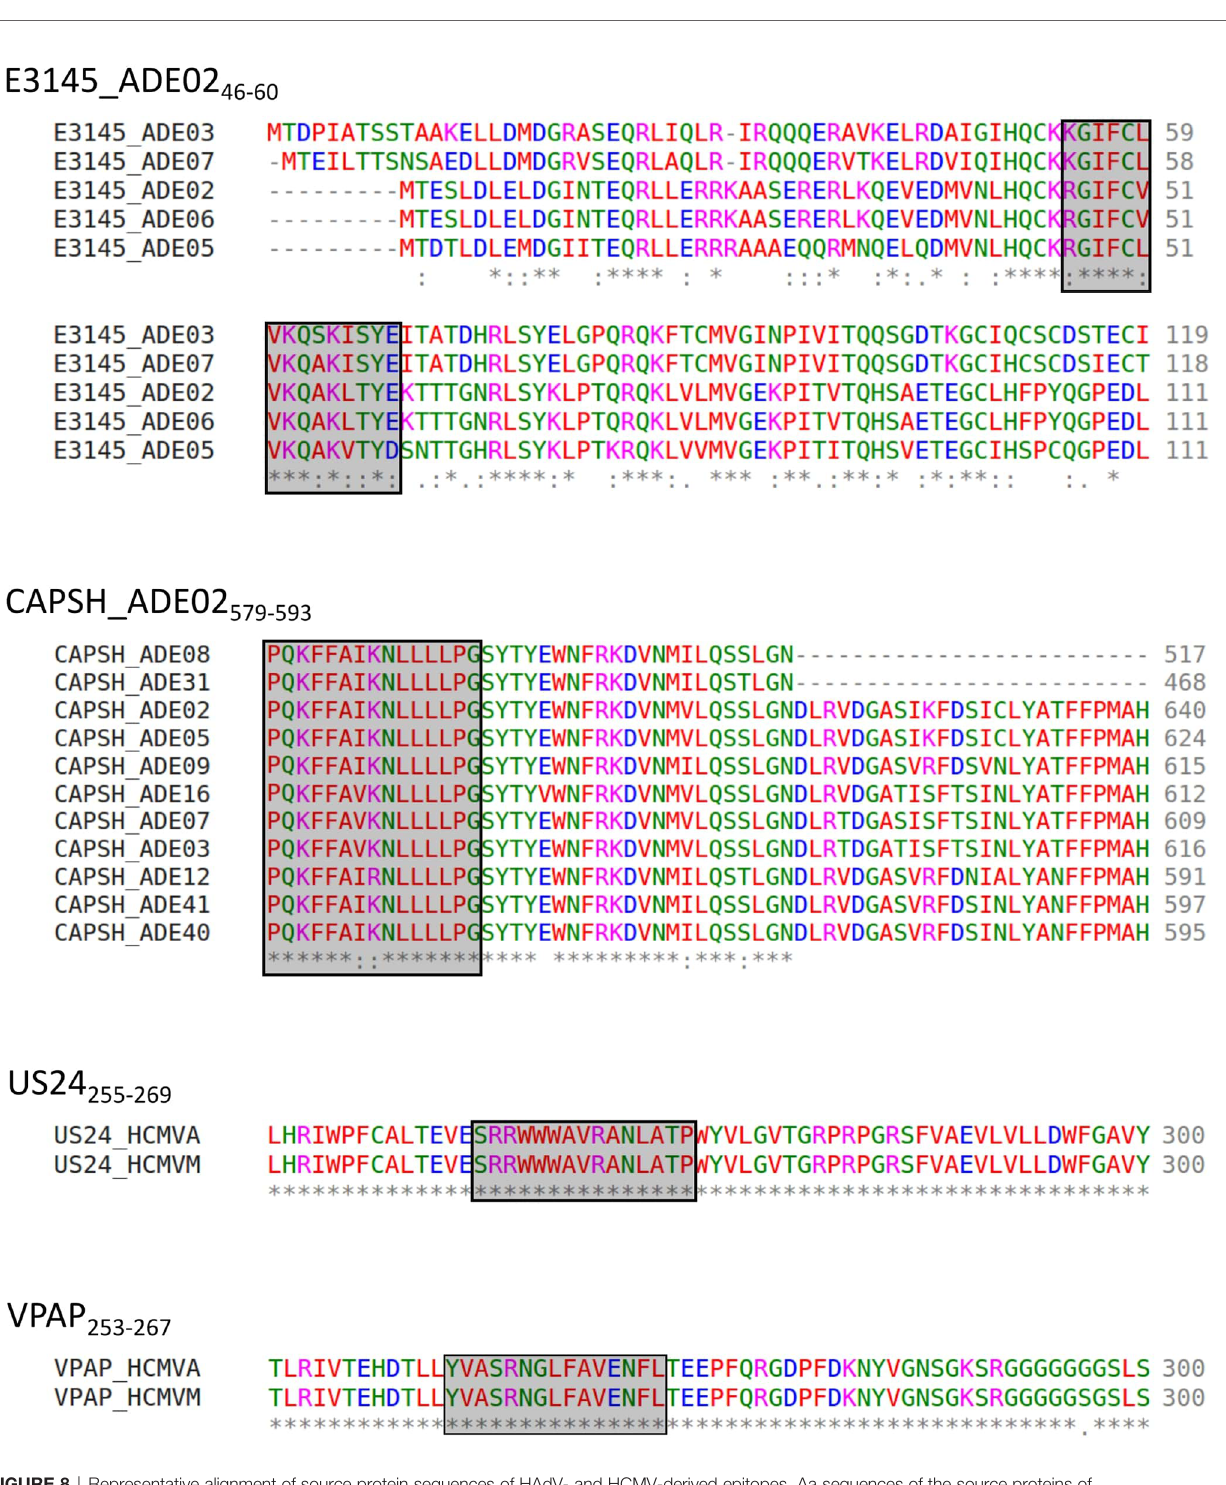
FIGURE 8 | Representative alignment of source protein sequences of HAdV- and HCMV-derived epitopes. Aa sequences of the source proteins of immunodominant epitopes present in the peptide pools were aligned to assess the conservation of epitope sequences among different strains. Representative alignment of four frequently recognized dominant epitopes. * indicates perfect alignment,: indicates strong similarity,. indicates weak similarity, The aa: A, V, F, P, M, I, L, W ( “ small + hydrophobic (incl. aromatic-Y) ” ) (45) are shown in red, D, E (acidic aa) in blue, R, K (basic aa) in magenta, S, T, Y, H, C, N, G, Q ( “ hydroxyl + sulfhydryl + amine + G ” ) (45) in green, and all other residues ( “ unusual amino/imino acids, etc. ” ) (45) are depicted in grey